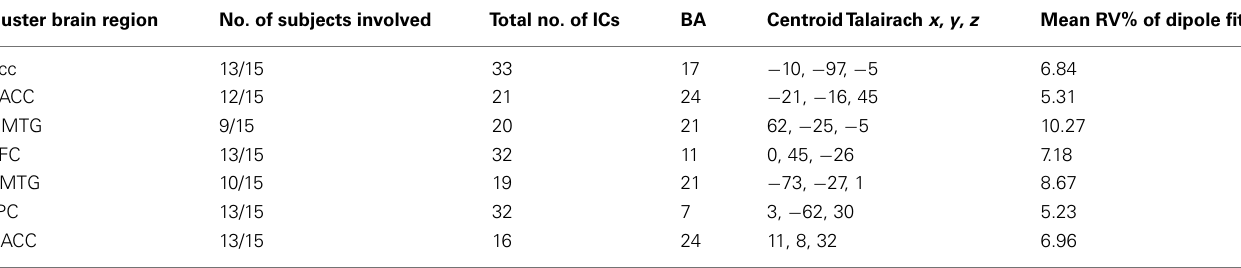
Table 1 | Cluster properties Experiment 1.